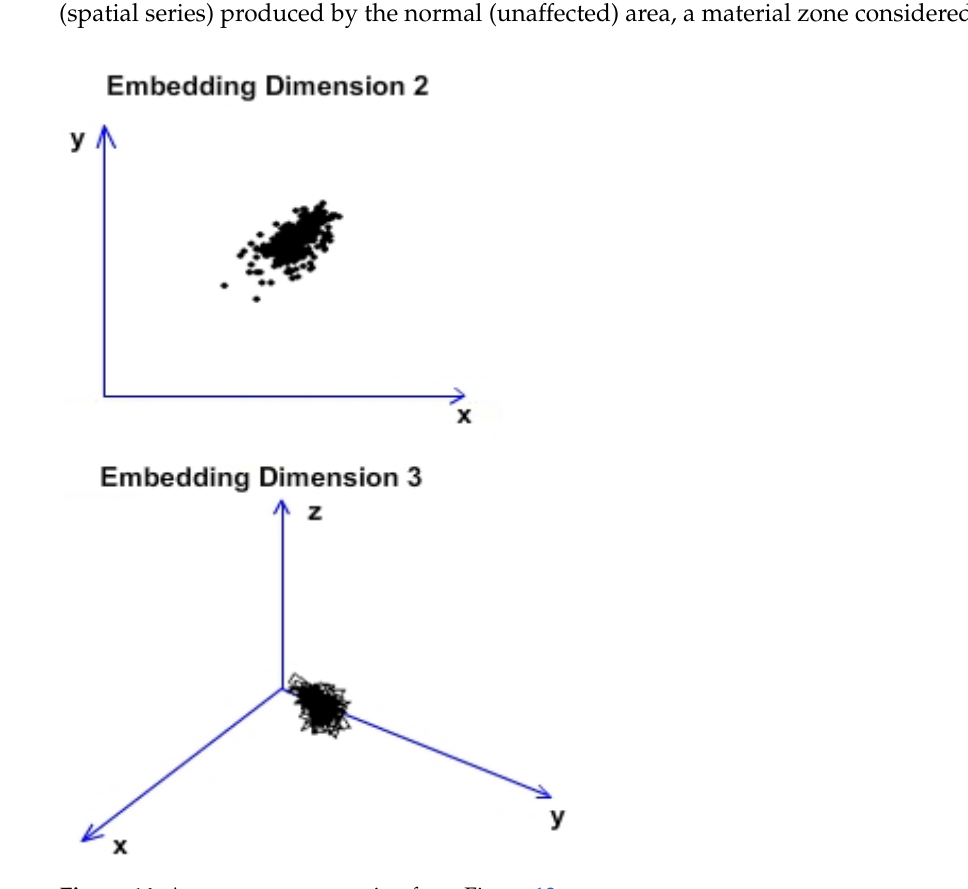
Figure 16. The slope of the autocorrelation dimension versus the embedding dimension for the nor- mal area. Figure 17 introduces the original image of the unaffected area in the yellow border. Figure 18 introduces the binary version of the image in the yellow box. Figure 19 intro- duces the process of applying the mask to the image, for lacunarity calculation. The blue box represents the area of interest.